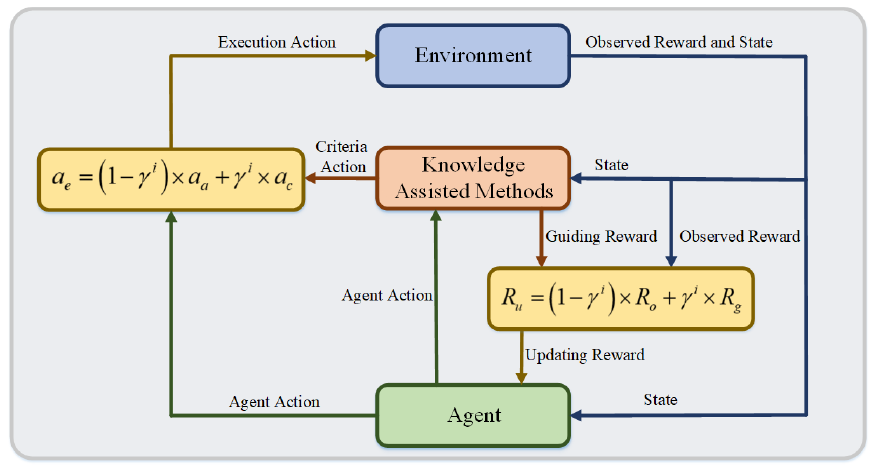
Figure 4. Framework of